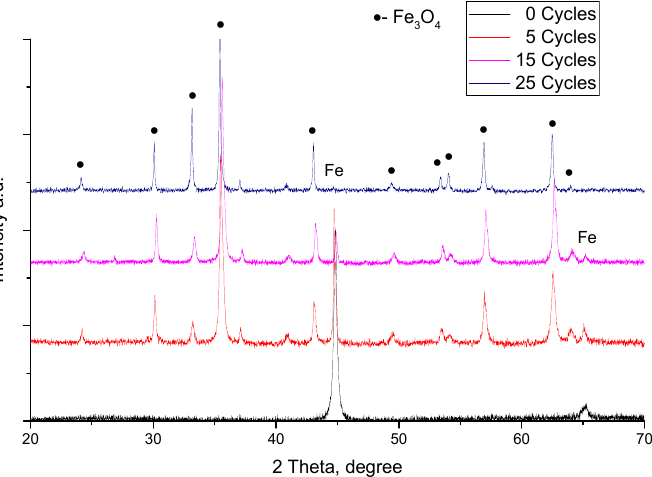
Figure 10. X-ray diffraction patterns of uncoated steel before and after heat treatment cycles. The XRD patterns of the as-sprayed Al 2 O 3 coating and after cycling heat treatment are given in Figure 11. As can be seen, there are noticeably fewer changes in the phase composition of the Al 2 O 3 coating after heating (Figure 11). The as-sprayed coating demon- strated the diffraction peaks at 2 θ = 25.6 ◦ 35.7 ◦ 43.5 ◦ 57.7 ◦ and 63.1 ◦ , which were attributed to the rhombohedral α -Al 2 O 3 phase [9,25,28]. The γ -Al 2 O 3 phase was also determined at 2 θ = 37.4 ◦ 38.9 ◦ 45.9 ◦ and 67.1 ◦ [22,25,28] The ratio of the highest intensity of α -Al 2 O 3 (at 43.5 ◦ ) and γ -Al 2 O 3 (at 45.9 ◦ ) peaks was 1.16 before heat treatment. The initial phase in alu- mina feedstock powder was only α -Al 2 O 3 . Thus, partial phase transformation from alpha to gamma-alumina occurred [9,11,29]. It is well known that the γ phase amount in Al 2 O 3 coatings is increased with the increase of the melting degree of the particle and/or the so- lidification rate of the alumina splats on the substrate [11,29]. During the rapid cooling and solidification process, the liquid droplets could nucleate and grow up forming crystalline phases as well as staying in an amorphous phase [22]. The intensity of the alpha phase peak at 43.5 ◦ slightly increased and the peak became sharper after 5 heating cycles. As a result, the α -Al 2 O 3 / γ -Al 2 O 3 ratio increased up to 1.49 after the first 5 heating cycles. The further increase of heating cycles enhances the intensities of α -Al 2 O 3 peaks. The α -Al 2 O 3 / γ -Al 2 O 3 ratio increased up to 1.81 after 15 cycles and the highest α -Al 2 O 3 / γ -Al 2 O 3 ratio of 1.84 was observed after 25 cycles. It was found that the α -Al 2 O 3 peak intensity increased while the γ -Al 2 O 3 peak intensity remained similar. This happens because the temperature is not high enough for phase transition reactions from α -Al 2 O 3 to γ -Al 2 O 3 phase to occur (950–1050 ◦ C). The temperature is high enough only to initiate amorphous Al 2 O 3 to the α -Al 2 O 3 phase transition. Dhakar et al. [25] described similar results where Al 2 O 3